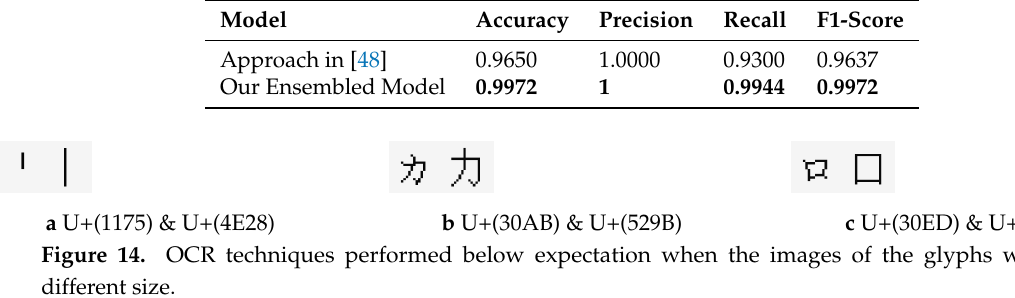
Table 6. Comparison with OCR based techniques. We focus on CJK characters only due to OCR techniques being limited to the number of characters it can classify.